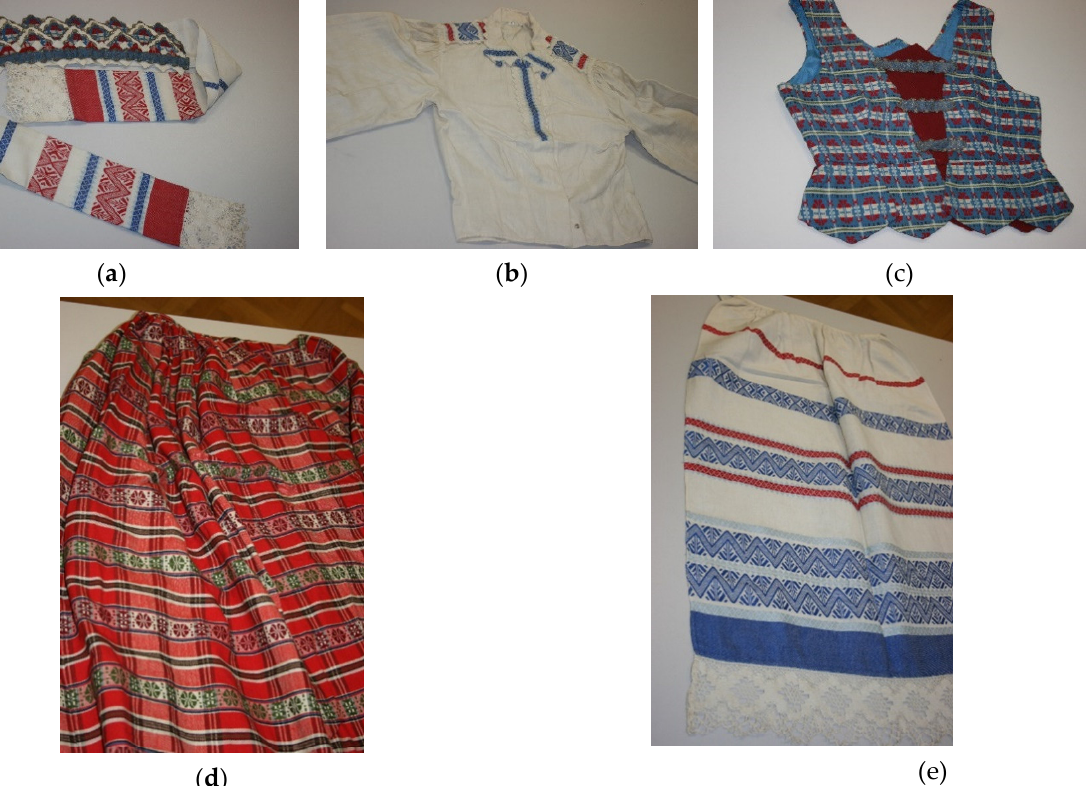
Figure 15. Folk costumes from Samogitia: ( a ) From Mažeikiai, Telšiai district, the 19th century: Skirt, A. and A. Tamošaitis gallery, Nr. 865; shirt LDM LA-1240; apron A. and A. Tamošaitis gal- lery, Nr. 903; vest LDM LA-2433; ( b ) from Raseiniai district, the 19th century: Skirt A. and A. Tamošaitis gallery, Nr. 858; shirt LDM LA-3019; apron A. and A. Tamošaitis gallery, Nr. 859; vest LDM LD-984/3.